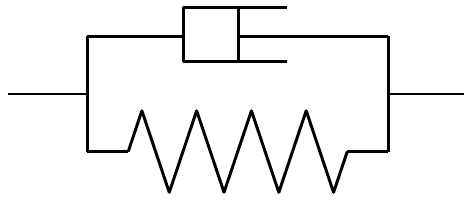
Figure 9. Schematic diagram of Kelvin model.